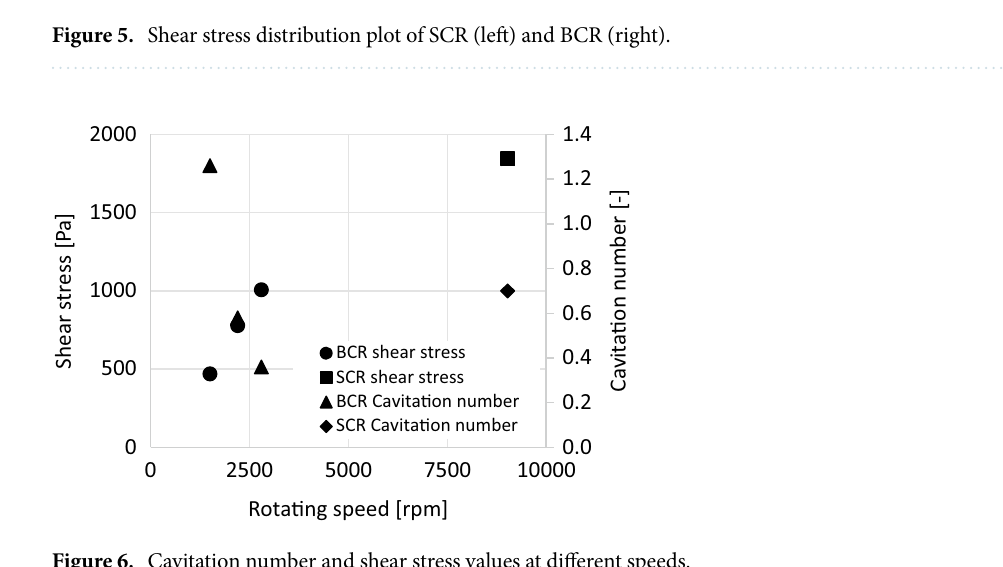
Figure 6. Cavitation number and shear stress values at different